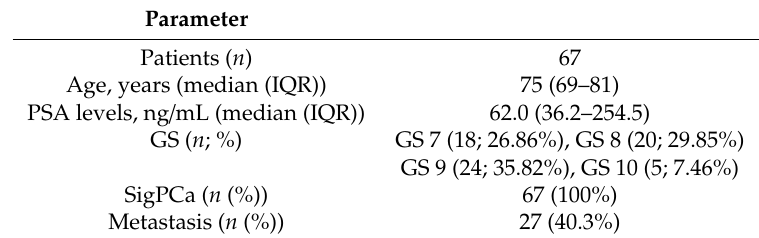
Table 2. Demographic, biochemical and clinical parameters of the patients who underwent prostate biopsy (Cohort